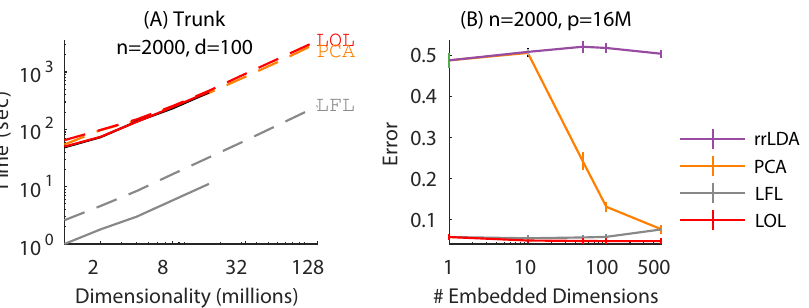
Fig. 2 Computational ef fi ciency and scalability of LOL using n = 2000 samples from spherically symmetric Gaussian data (see Supplementary Note 3 for details). A LOL exhibits optimal (linear) scale up, requiring only 46 min to fi nd the projection on a 500 gigabyte dataset, and only 3 min using LFL (dashed lines show semi-external memory performance). B Error for LFL is the same as LOL in this setting, and both are signi fi cantly better than PCA and rrLDA for all choices of projection dimension, regardless of whether a randomized approach is used to compute the projection dimensions. Note that while similar scalability enhancements can be made to PCA in ( A ), our focus is to highlight that LFL maintains the high performance of LOL in comparison to PCA in ( B ) despite the randomization